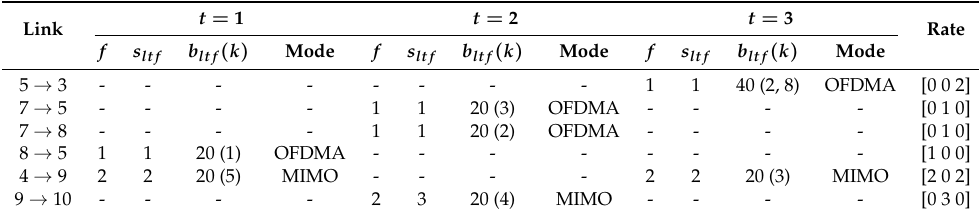
Table 4. Resource Allocation Result for Case 1.